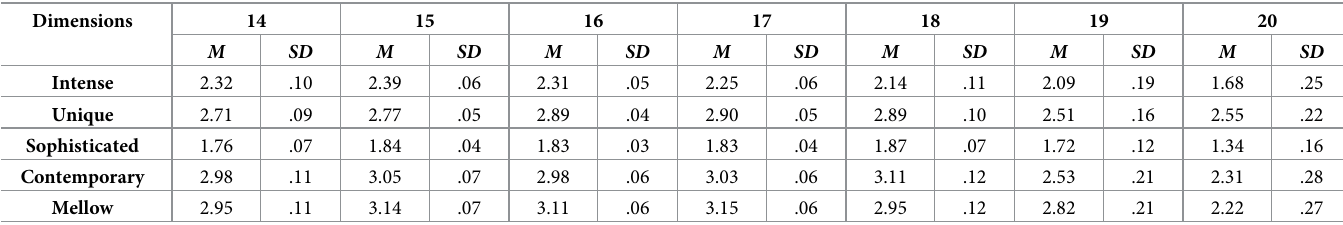
Table 3. Descriptive statistics for musical preferences regarding